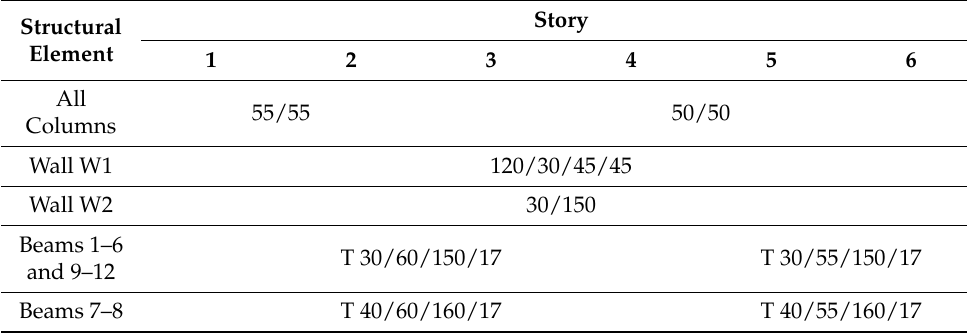
Figure A1. Numbering of structural members in the analysis model of the six-story building. Table A1. Member sections of the six-story building (in cm).